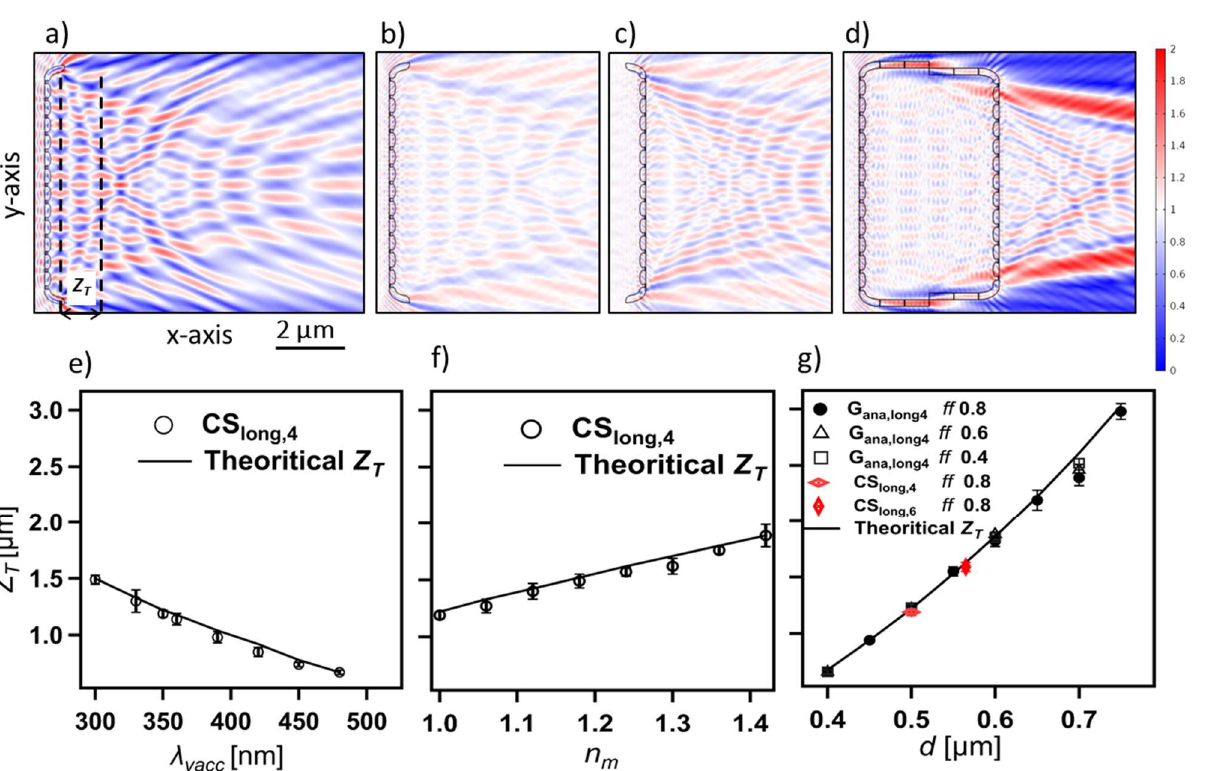
Figure 9. The interference pattern of CS long,4 displays the Talbot pattern dominating the transmittance region at λ vacc = 350 nm in air ( a ) and in water for the light incident on the external face ( b ) or the internal face ( c ). The distance between the two black, dashed lines (considered as the Talbot planes) in ( a ) is the so-called Talbot length ( Z T ). The Talbot pattern in CS long,4, frustule at λ vacc = 350 nm immersed in water ( d ). The graphs illustrate the Z T dependency on λ vacc in CS long,4 in air ( e ) and on n m ( n v = 1.46) at λ vacc = 350 nm ( f ). A graph shows the Z T dependency on d of G ana,long4 with different fill factors ( ff ) at λ vacc = 350 nm in air ( g ). The error bars in the graphs represent the uncertainty in the measured Z T